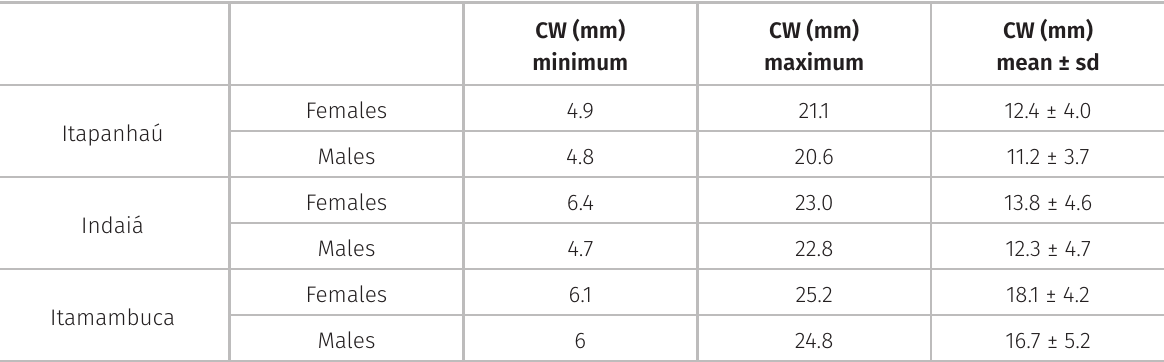
Table II. Descriptive features of Minuca vocator populations from Itapanhaú, Indaiá, and Itamambuca mangroves. CW = carapace